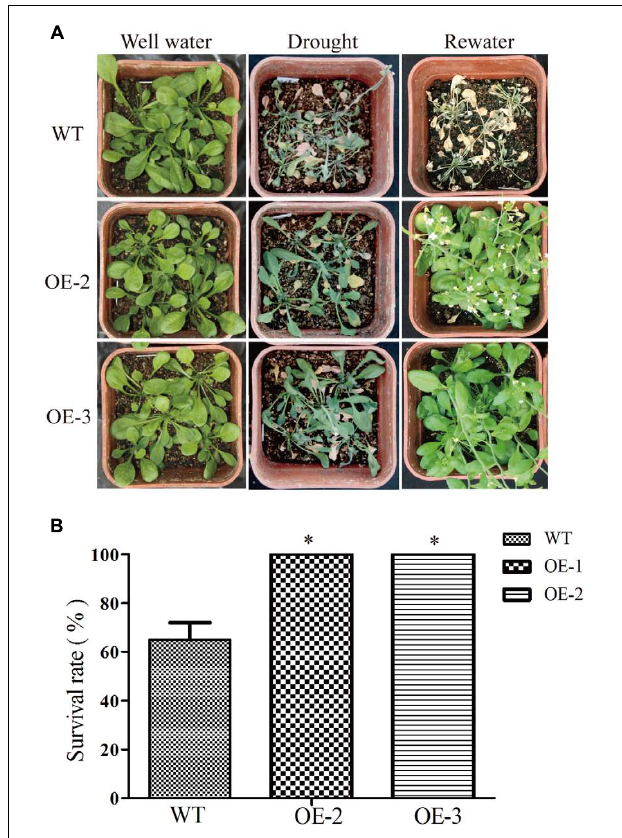
FIGURE 13 | Drought tolerances in Arabidopsis overexpressing GmRAV-03 and wild type. (A) Performance of WT and GmRAV-03 -overexpressing lines OE2 and OE3 before and after drought stress at the seedling stage. (B) Survival rate of WT and GmRAV-03 -overexpressing lines after drought stress ( n = 3). The data are shown as mean ± SD ( n = 45). Independent t -tests demonstrated that there was significant difference ( ∗ P <